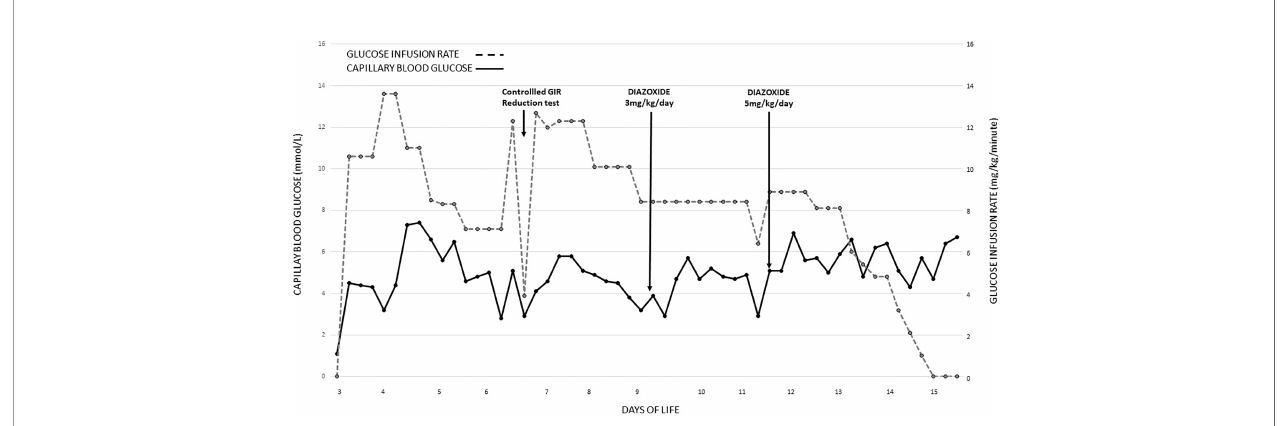
FIGURE 1 | Blood glucose recordings and glucose infusion rates were required from day 3 of life till glucose control was achieved with diazoxide. GIR, glucose